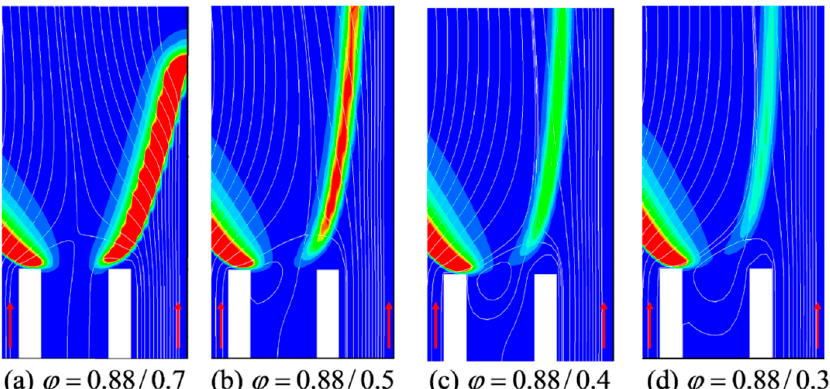
Figure 6. With the color-coded heat release rate distribution as the background, the streamline patterns show lateral impingement of the post-flame flow between the two flames with the varied center flame equivalence ratio ϕ = 0.7–0.3 and fixed outer flame ϕ = 0.88 (arrow indicates inlet flow direction).